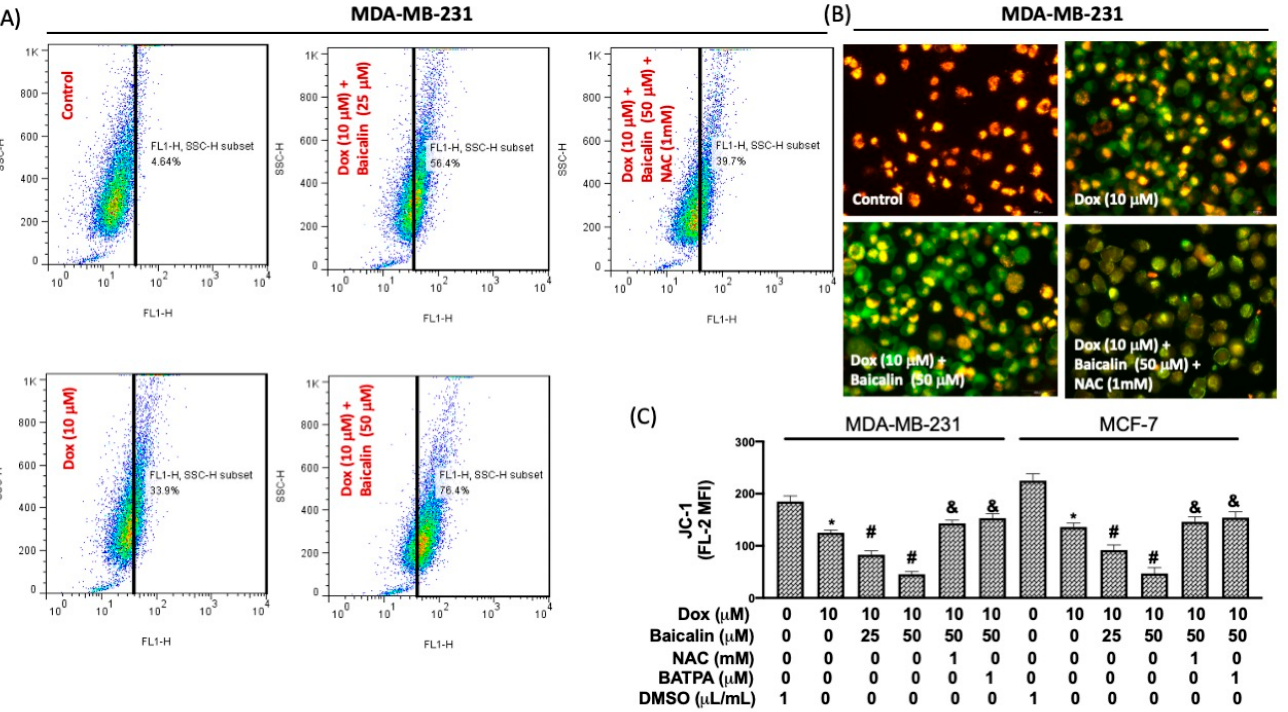
Figure 3. Baicalin increases intracellular calcium concentration and impairs mitochondrial membrane potentials. Cells were treated with 10 µ M Dox or 10 µ M Dox plus 50 or 25 µ M baicalin for 24 h. Fura-3 AM was used to reveal the intracellular calcium concentration by flow cytometry. Combined treatments (baicalin plus Dox) showed a massive increase in the number of positive cells compared to Dox alone. In some cells, NAC pretreatment inhibited oxidative stress ( A ). The mitochondrial membrane potential was investigated using fluorescent microscopy ( B ) and flow cytometry ( C ) with JC-1. Red fluorescence denotes the potential-dependent aggregation of JC-1 within polarized mitochondria in healthy cells, and green fluorescence denotes depolarized mitochondria in unhealthy cells or apoptotic cells. Data are expressed as the mean ± SEM of three independent analyses; * p < 0.05 versus untreated control, # p < 0.05 versus Dox treatment, & p < 0.05 versus Dox+Baicalin (50 μ M) treatment.